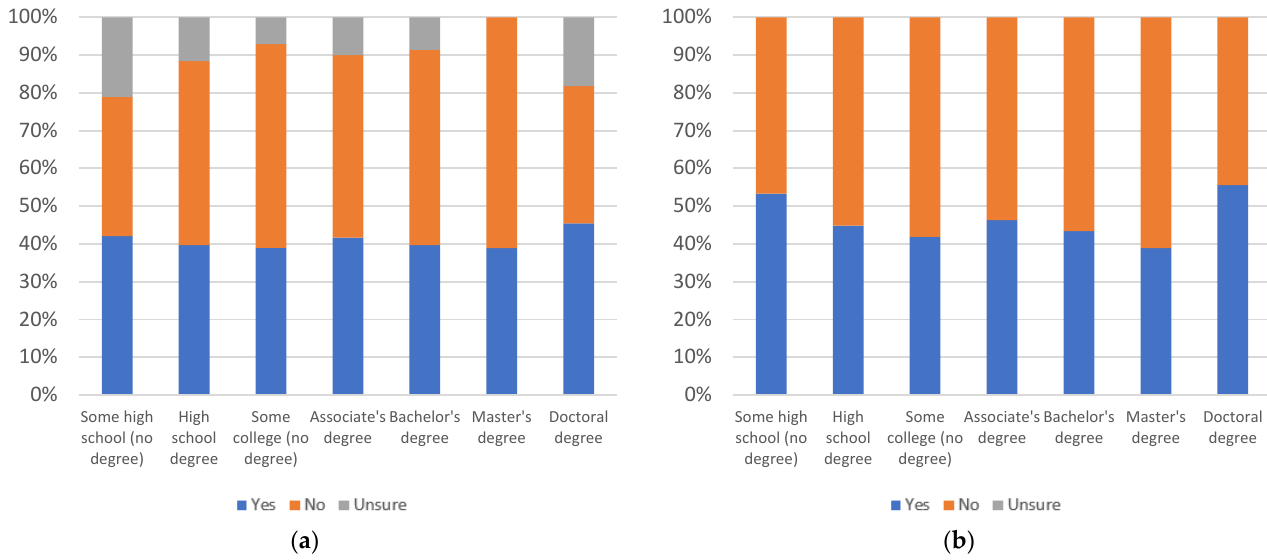
Figure 57. Label annoyingness, by education level: ( a ) with uncertain respondents (left) and ( b ) without uncertain respondents (right).